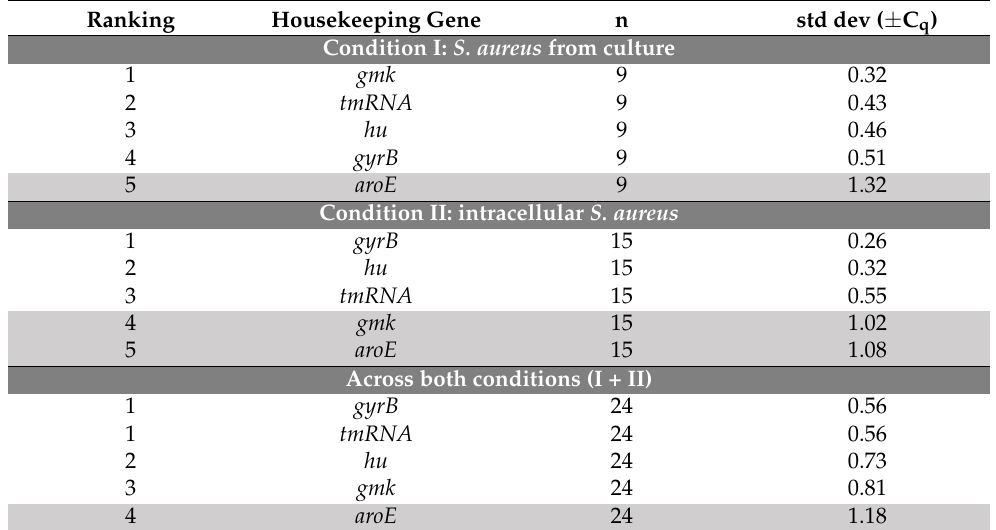
Table 4. Ranking of bacterial housekeeping genes. n: number of independent experiments carried out for each condition; std dev: standard deviation; C q : crossing point. Values highlighted in grey were excluded from further